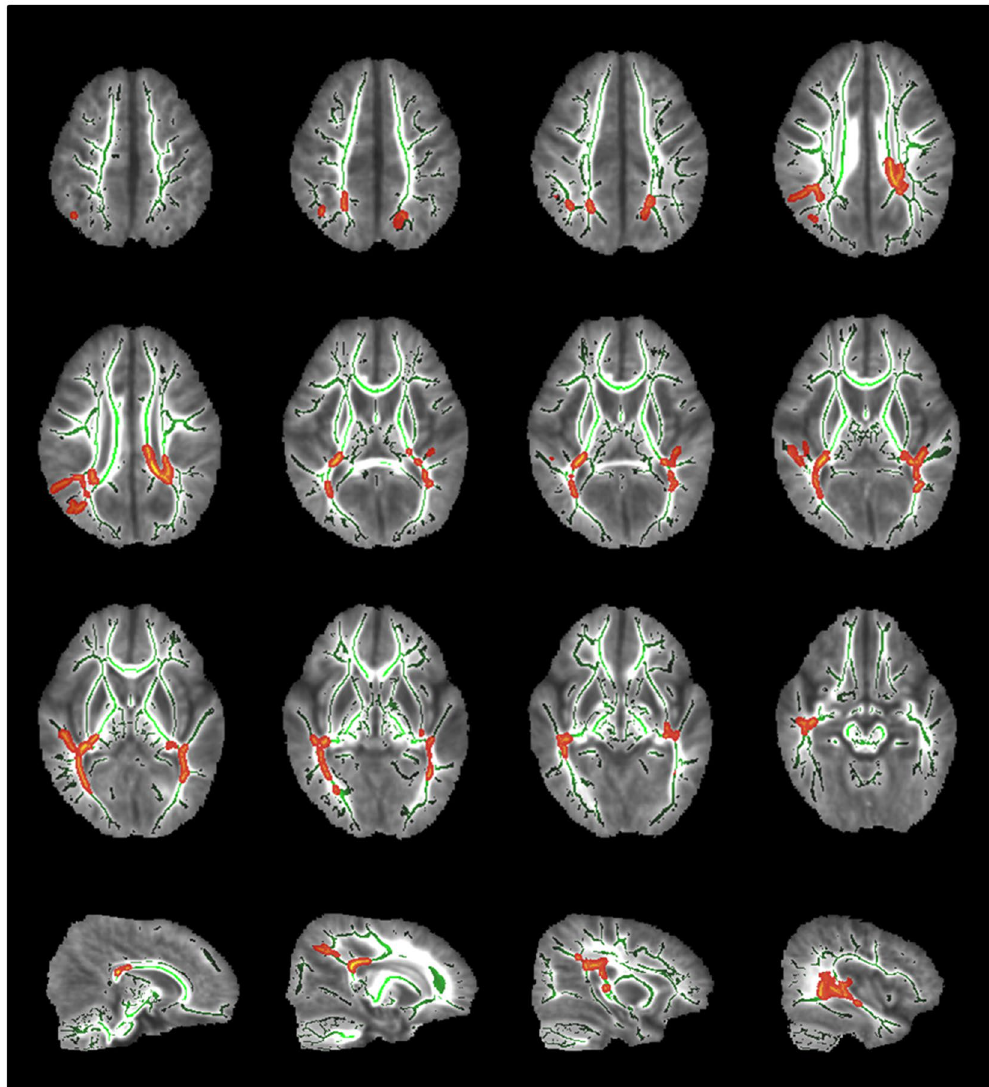
Figure 4. TBSS results. Comparisons of the mean FA maps of preterm infants at 18–22 months of corrected age between the SHP-2 variant and control groups. Mean FA skeleton is shown in green, and areas with significant differences between the two groups are shown in red-yellow ( P < 0.05). The FA value in the corpus callosum, posterior limb of internal capsule, and optic radiation was lower in the variant group.